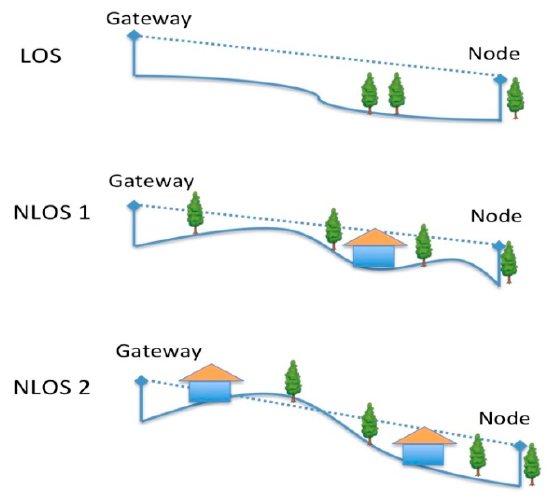
Figure 14. LoS and NLoS tests, map.